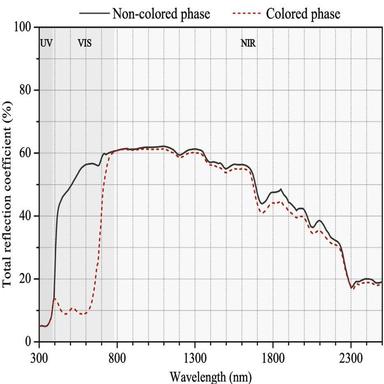
Comparison between the optical response of the thermochromic roof coating in the colored and non-colored phase.